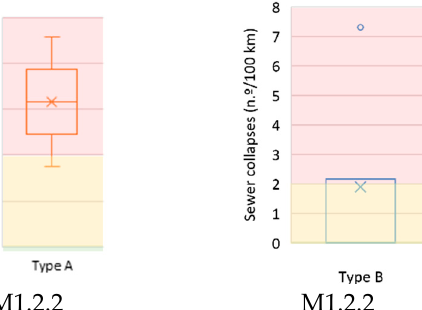
Figure 6. Results of the validation applied to the wastewater utilities: objective 2.